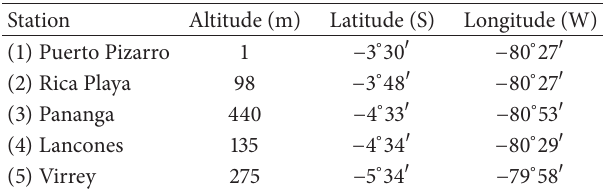
Table 1: Names and locations of the meteorological stations with rainfall data from 1965 to 2008.